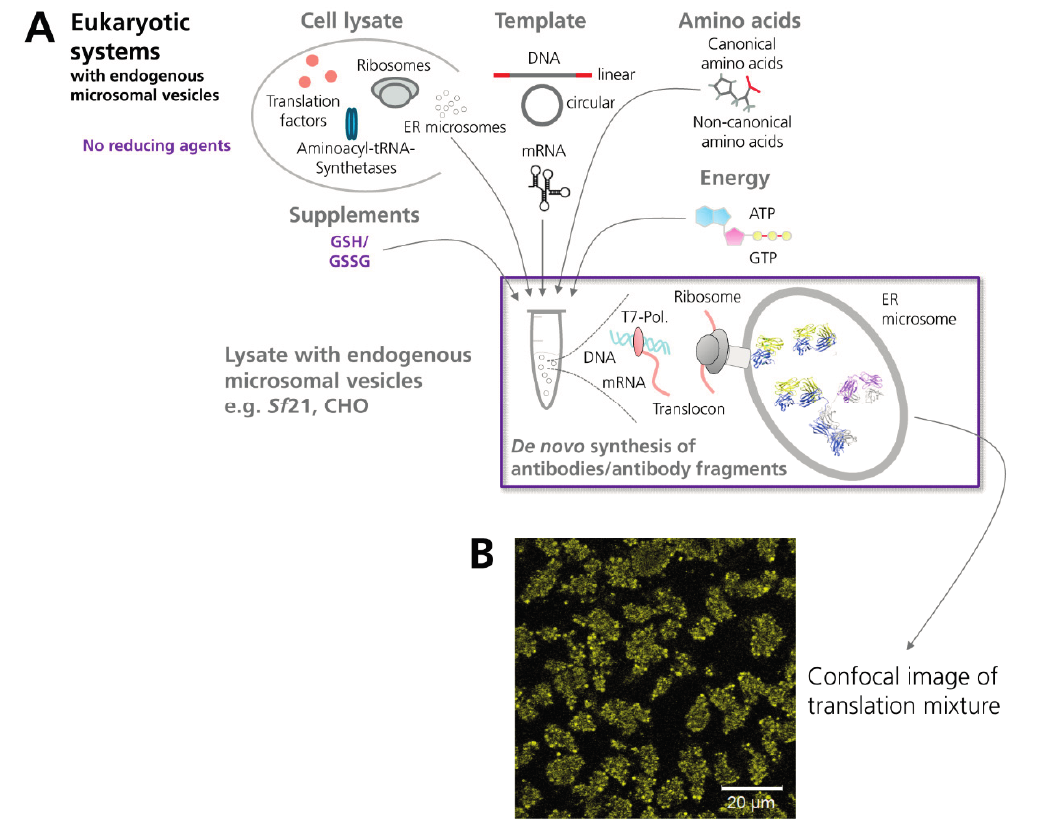
Figure 2. Scheme showing the cell-free synthesis of antibodies and antibody fragments in vesicle-containing eukaryotic in vitro translation systems. ( A ) The eukaryotic cell extract depicted in the scheme (e.g., based on lysates from Sf 21 or CHO cells) comprises endogenous microsomal vesicles. These vesicles enable a co-translational translocation of target proteins into their lumen and subsequent posttranslational modifications, such as the formation of disulfide bonds, which is one of the hallmarks of antibody domains. ( B ) Confocal image of cell-free synthesized scFv-eYFP fusion molecules which have been N-terminally fused to the melittin signal sequence. The signal sequence induces translocation of de novo synthesized molecules into the endogenous microsomal vesicles present in the insect ( Sf 21) cell-free translation system. (NMR structure antibody molecule, source: Protein Data Bank, 1 1IGT,